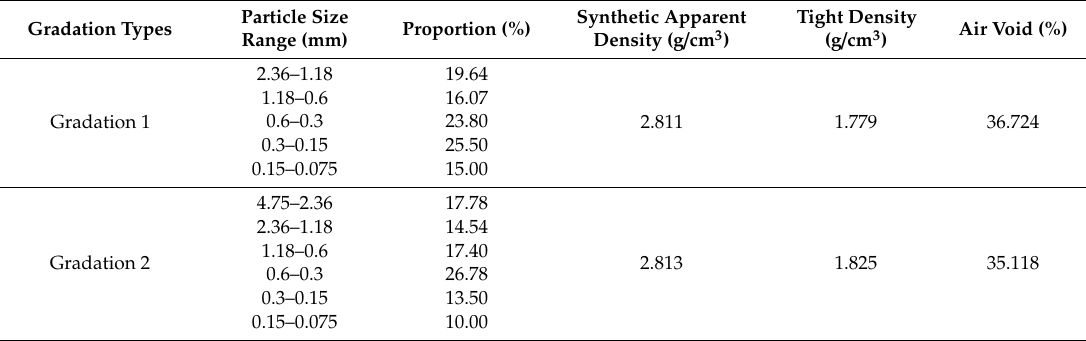
Table 8. Fine aggregate grading